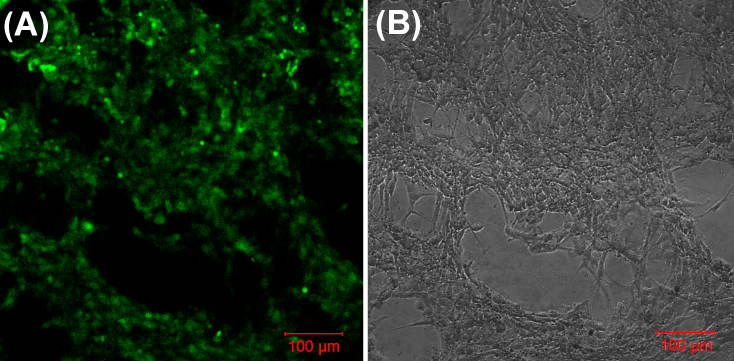
Figure 4. Cyto-compatibility of the poly- L -lysine-coated hydrogels. Shown in ( A ) are mouse mesenchymal stem cells (MSCs), prestained with PKH-67, growing uniformly across the gel; in ( B ), a brightfield image of the same is shown.